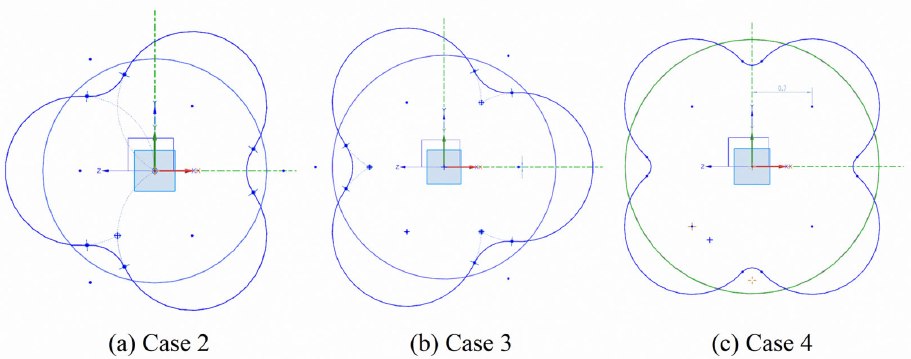
Figure 4. Schematic diagram of the lobe-shaped cooling holes .